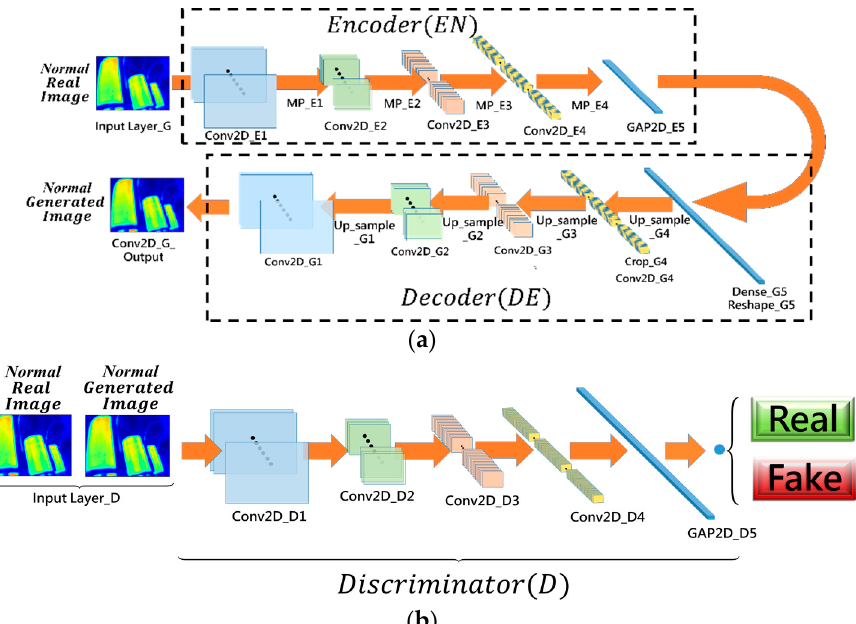
Figure 3. The detailed structure of the WAR model ( a ) with the discriminator network ( b ) of the proposed method.